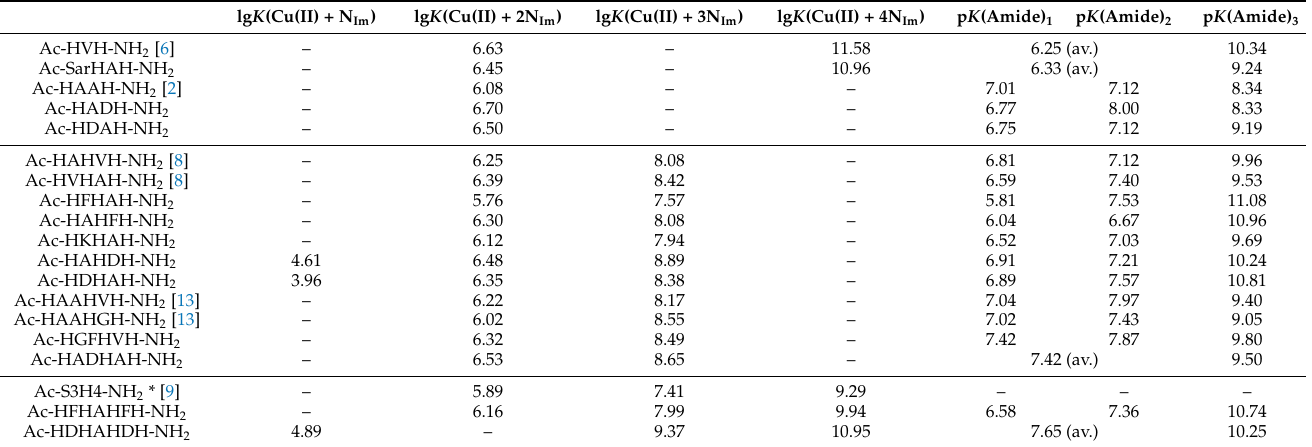
Table 2. Derived equilibrium constants of imidazole-coordinated complexes and deprotonation constants of amide nitrogen coordinated